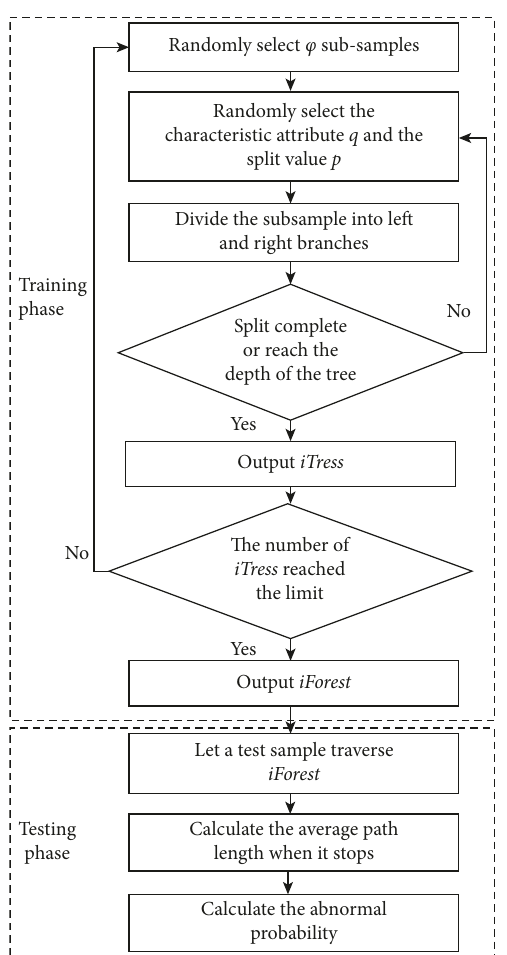
Figure 7: Algorithm flowchart.